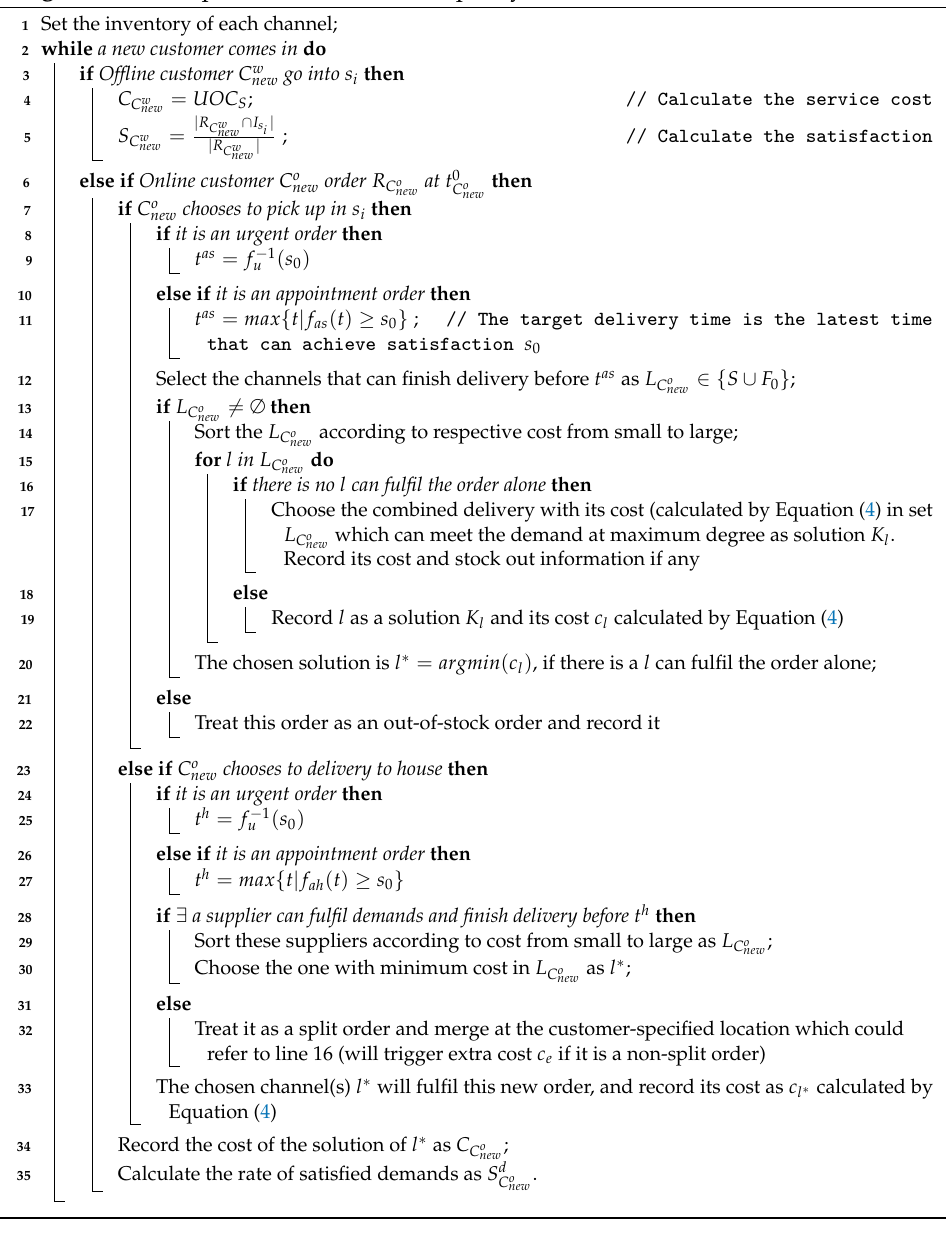
Algorithm 1: Proposed order fulfilment policy for